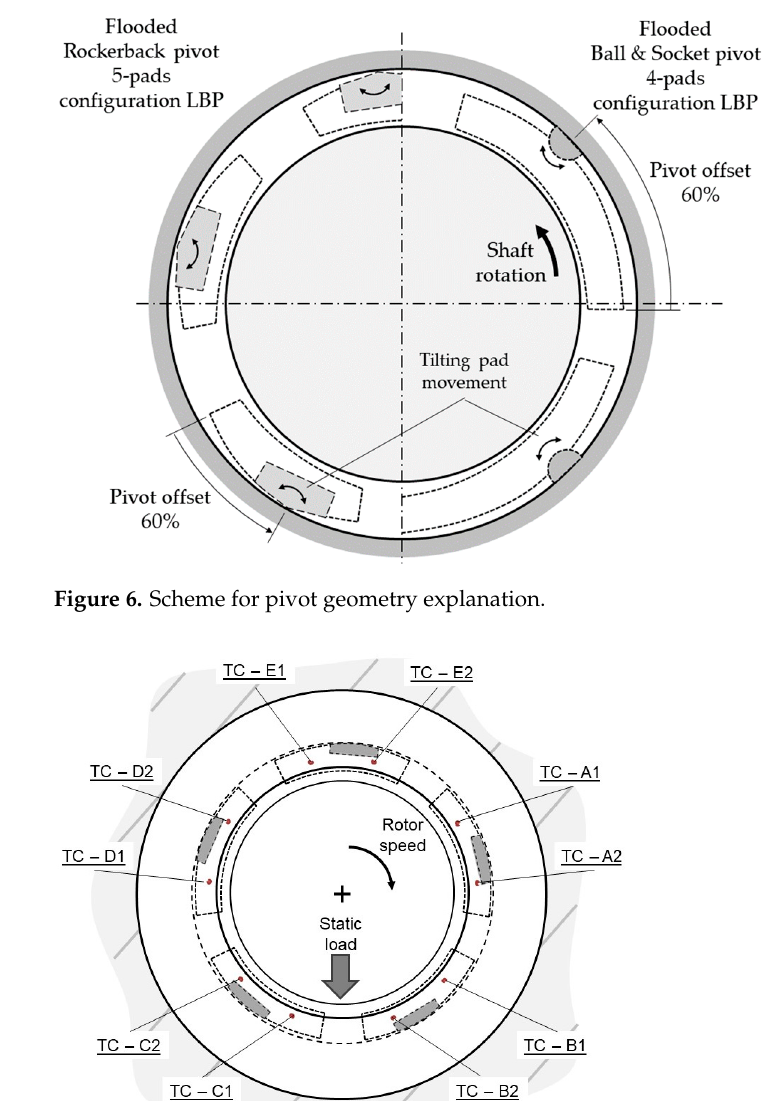
Figure 6. Scheme for pivot geometry explanation.